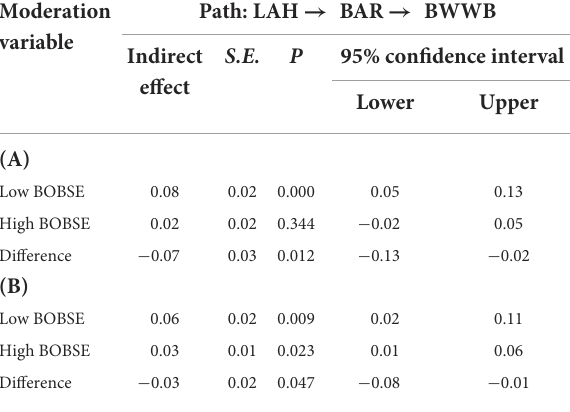
TABLE 5 Moderated mediation effect test